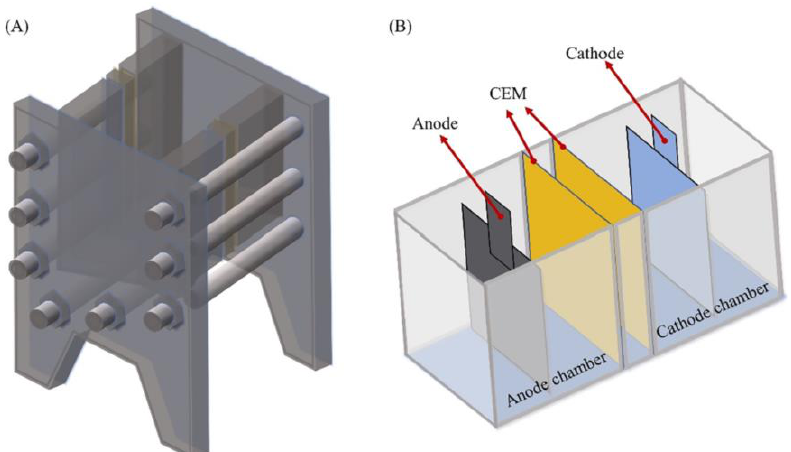
Figure 4. Schematic diagram of the electrodialysis device. ( A ) An assembled cell and ( B ) the placement of electrodes and CEMs in the cell. Reprinted from Desalination , 474, G. Liu, Z. Zhao, L. He, Highly selective lithium recovery from high Mg/Li ratio brines, 114185, Copyright (2020), with permission from Elsevier.